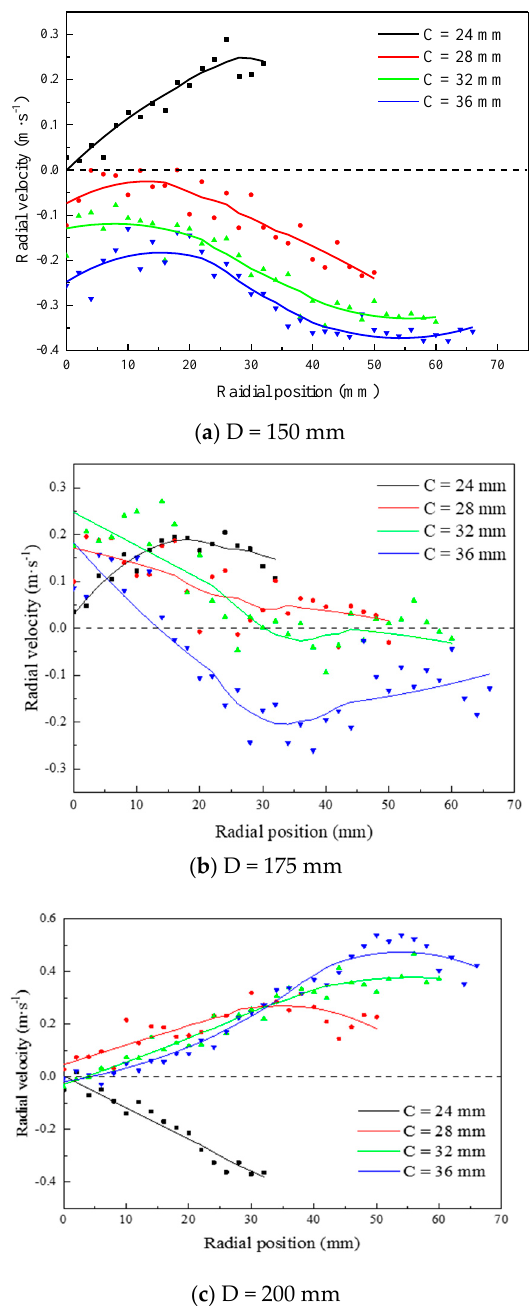
Figure 6. Radial flow velocity distribution on a horizontal line at 6 mm below the impeller blade